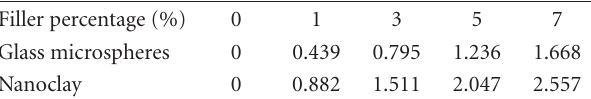
Table 2: Changes in optical density (OD) at 600 nm for B-side ma- terials containing various filler percentages.